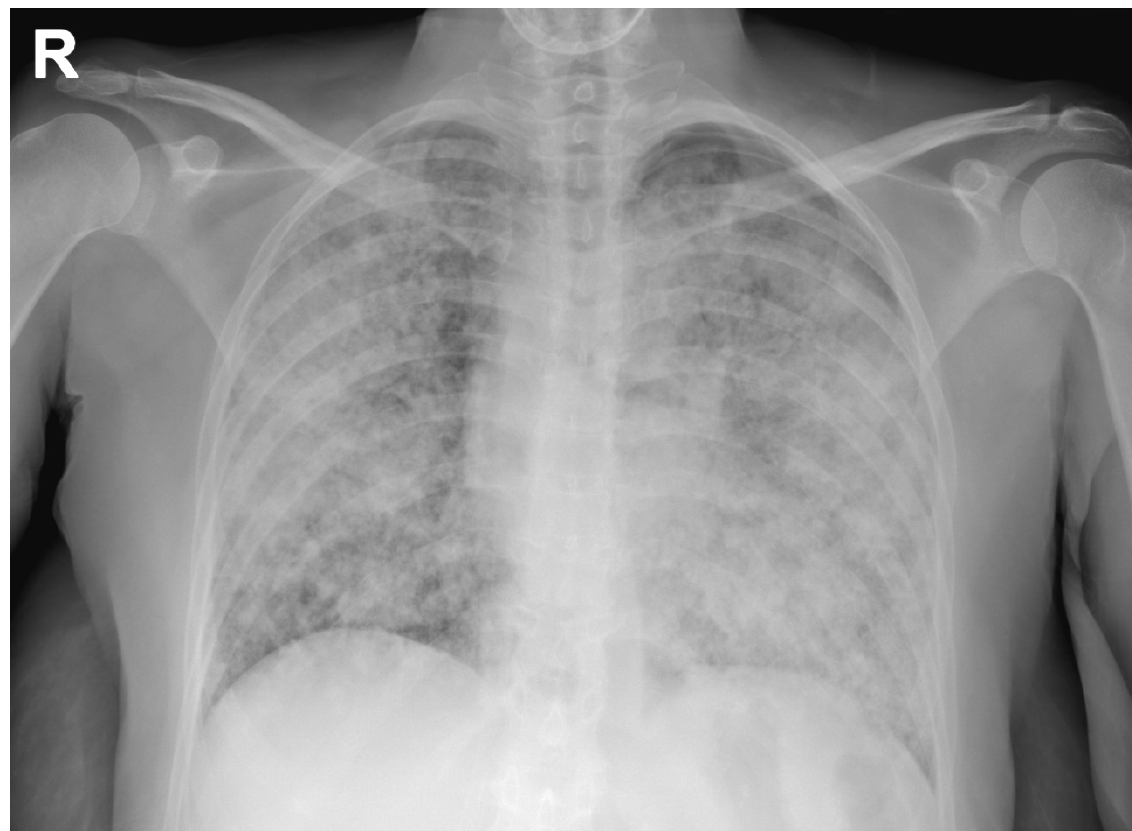
Figure 1. Chest radiograph showing a diffuse, alveolar and interstitial lung involvement with coalescing micronodules, simulating a non-specific alveolar opacification of the lungs (galaxy sign) (R: right side).